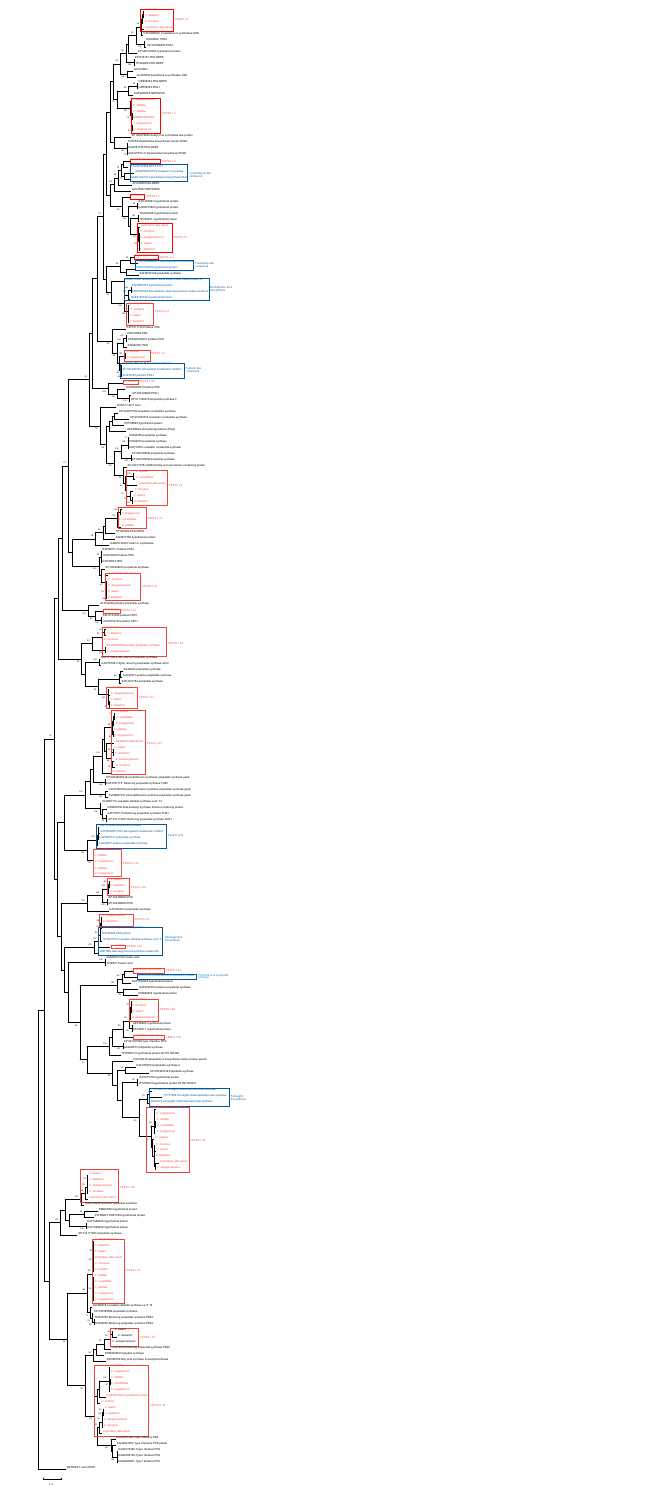
Figure 1. Maximum likelihood tree of 116 and 128 Verticillium and other fungi beta-ketoacyl synthase (KS) domains of the reducing PKS-I gene sequences, respectively, that were used in this study. The 26 main clades recovered for the Verticillium species are labeled from VRPKS-I-1 to VRPKS-I-26. Similar groups were obtained with the neighbor-joining analysis. GenBank accession numbers for each of these sequences are provided. In this analysis, we used 1000 bootstrap repeats as indicated in the